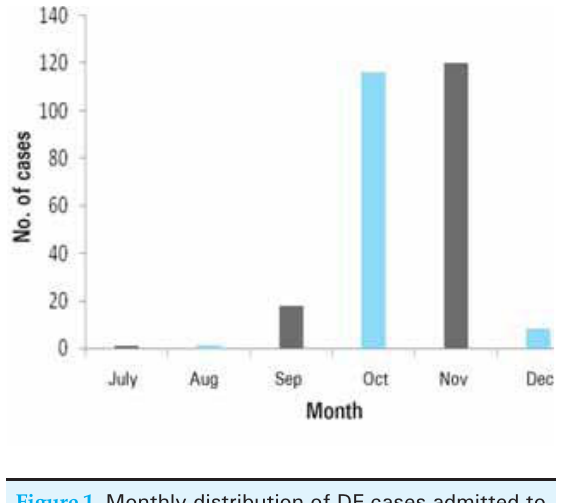
Figure 1. Monthly distribution of DF cases admitted to STIDH in 2010, Kathmandu,